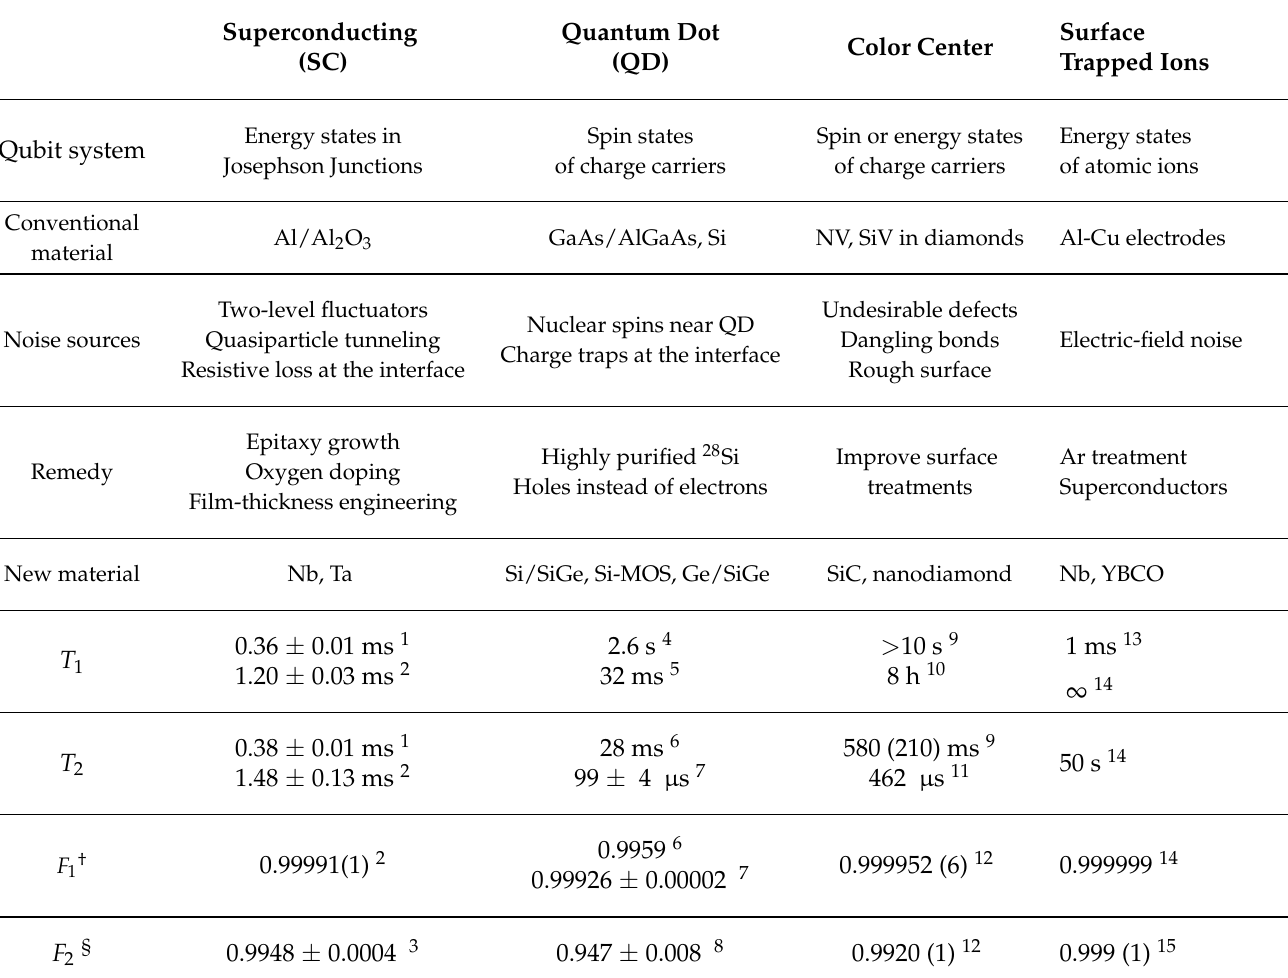
Table 2. Summary of qubit platforms involved in solid-state